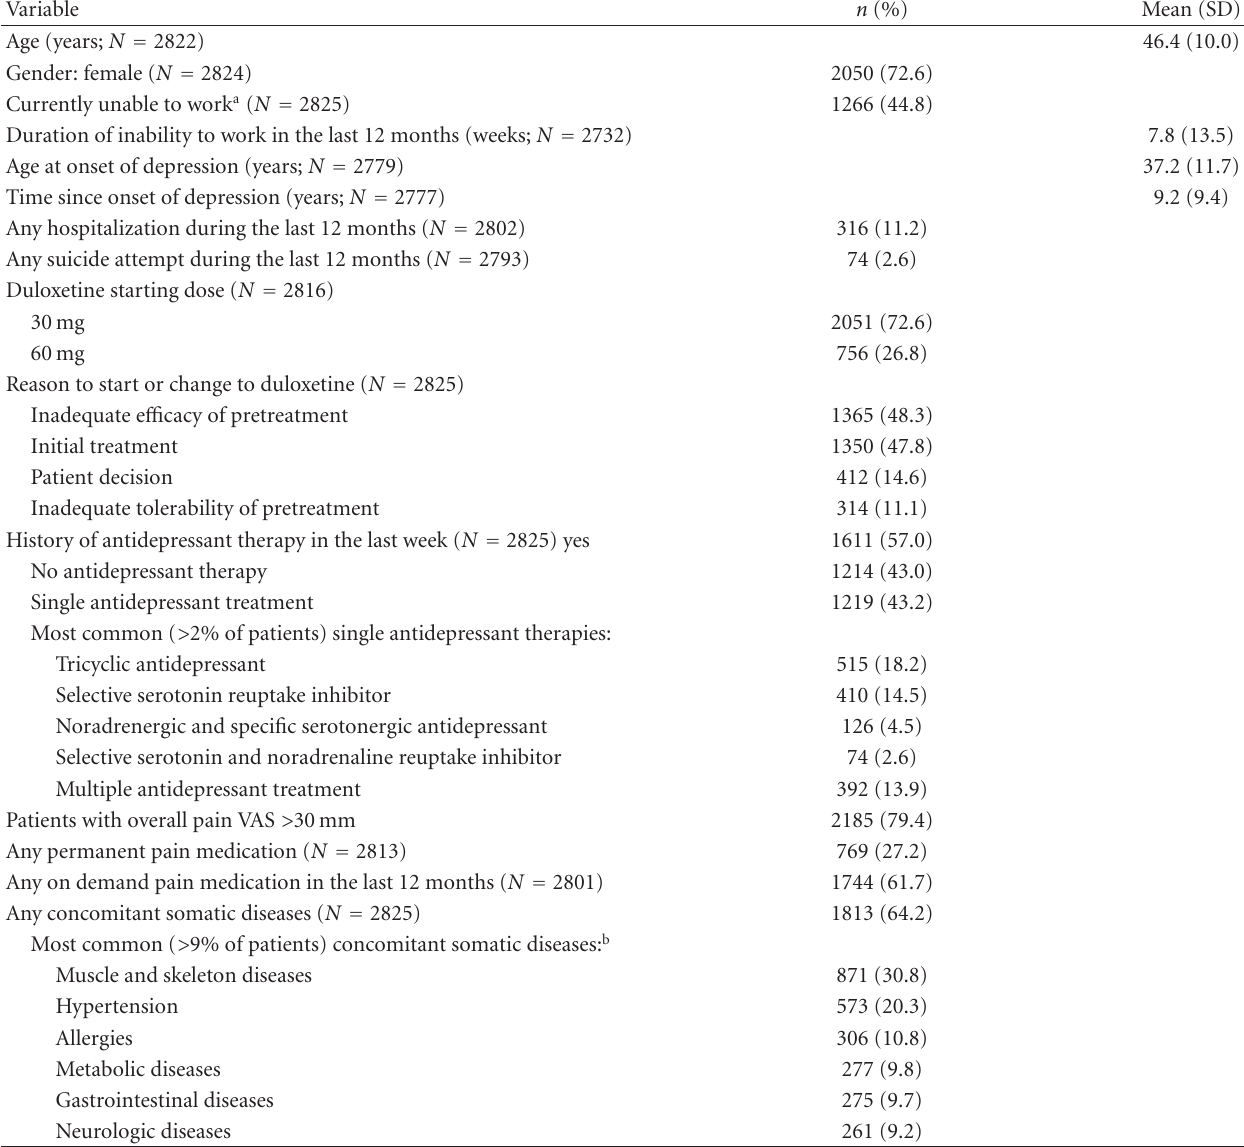
Table 1: Baseline